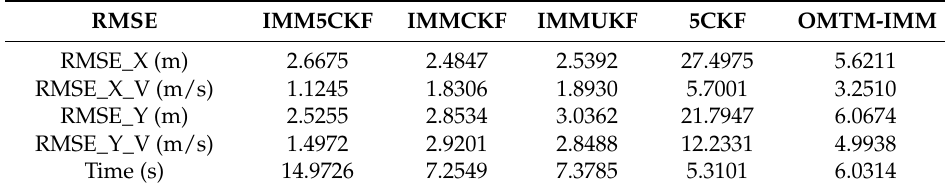
Figure 4. RMSEs of ( a ) X-velocity and ( b ) Y-velocity. Table 1. The RMSEs of the different target tracking algorithms.